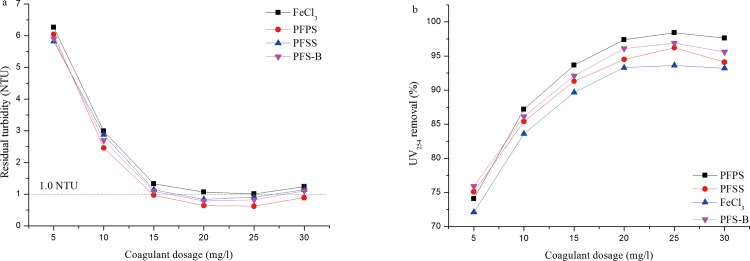
The comparison of PFS-B, FeCl3, PFSS and PFPS on (a) Turbidity reduction and (b) UV254 removal.